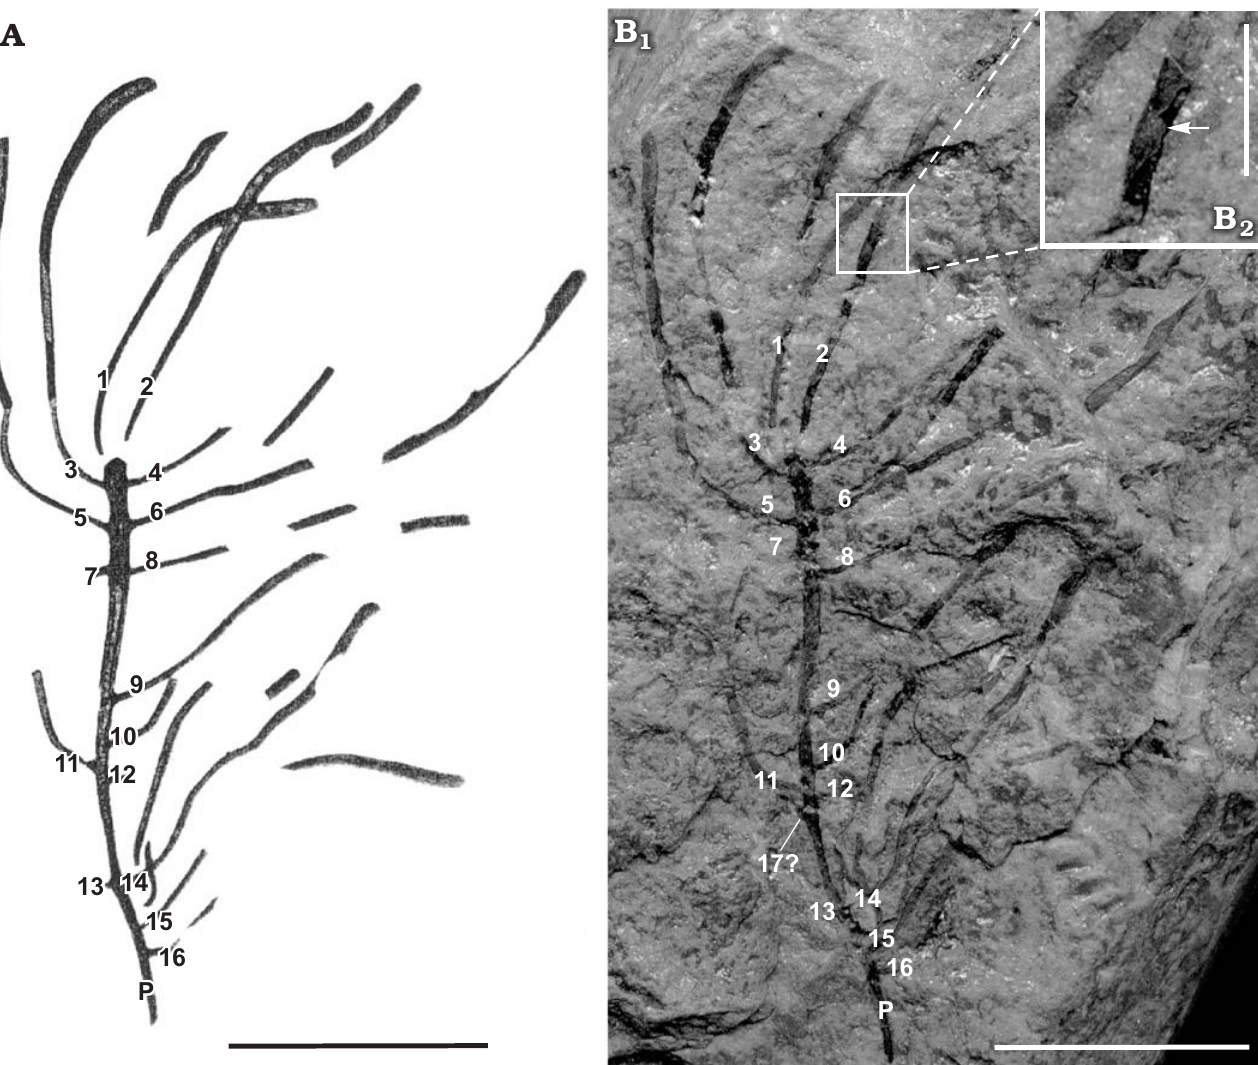
Fig. 4. Medusozoan cnidarian Sphenothallus sica Salter, 1856 (DNPM 329) from the Early Devonian Ponta Grossa Formation, Paraná State, southern Brazil. The numbers 1–16 indicate the evident, marginal daughter tubes, while the letter P indicates the parent tube. A . Reproduction of Clarke’s (1913) drawing. B . Light photographs. B 1 , general view; 17?, the possible basal portion of a seventeenth daughter tube; B 2 , detail, the arrow indicates a short longitudinal cross section through one of the marginal thickenings. Also present, near this site, is apparent spalling of fine lamellae. Scale bars: A, B 1 , 16 mm; C, 4 mm. A A A 2 3